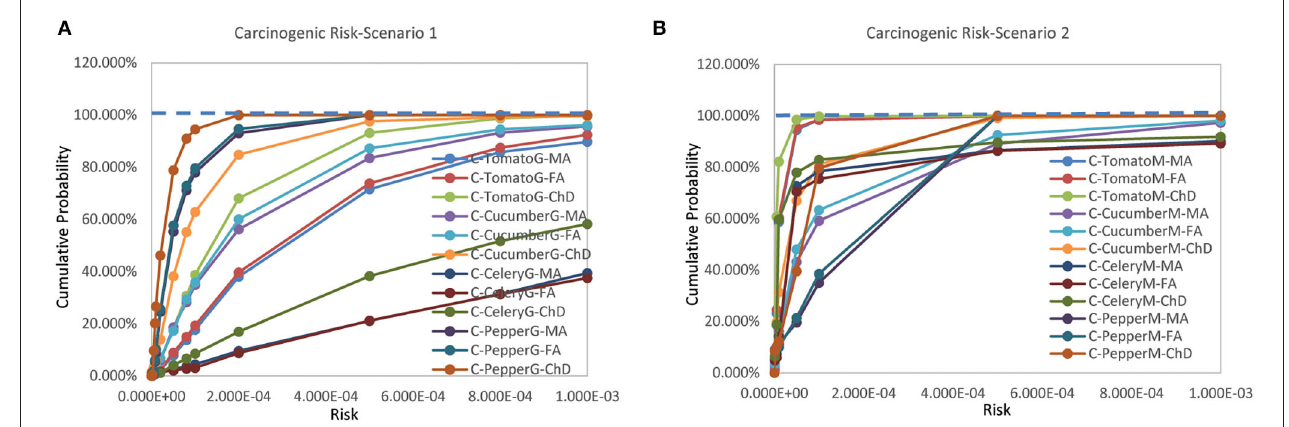
FIGURE 2 | Cumulative probability of carcinogenic risks for (A) scenario 1 and (B) scenario 2 (Jinan, China,